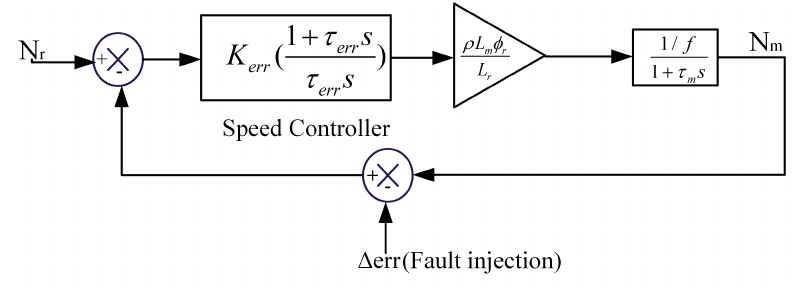
Figure 4. Speed control